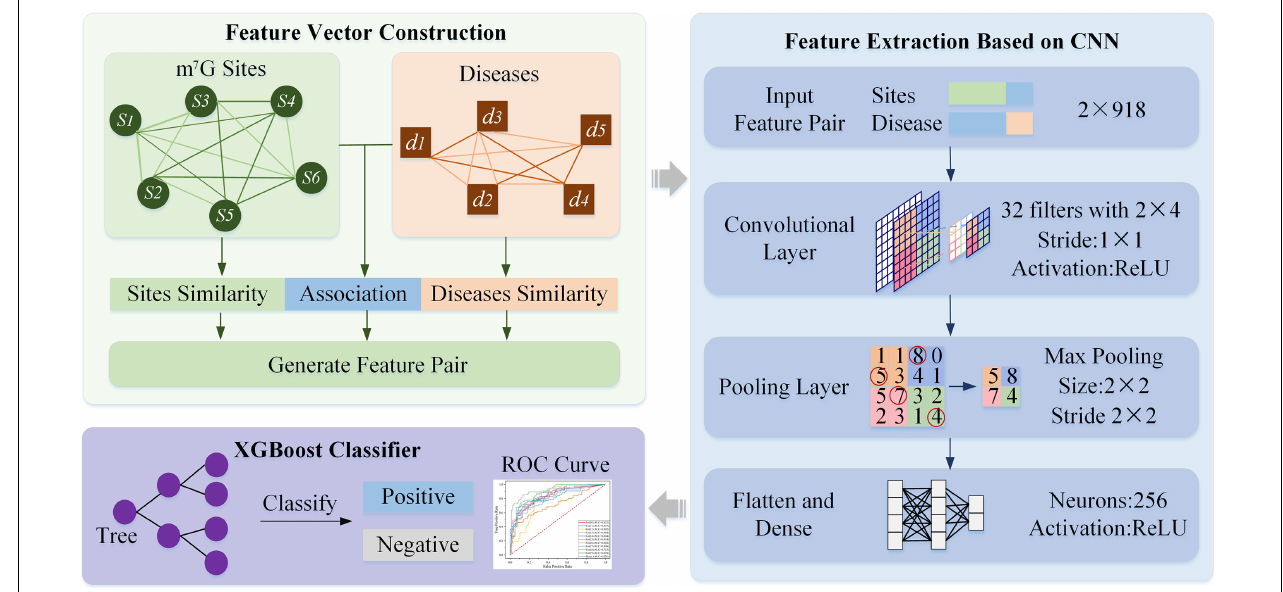
FIGURE 1 | Framework of HN-CNN. “Feature Vector Construction” is a heterogeneous network based on feature extraction, which is constructed with similarities and known m7G-disease association. “Feature Extraction Based on CNN” is a CNN-based feature extraction followed by XGBoost. In “XGBoost Classifier,” XGBoost predicts the candidate samples, which chooses the regression classification tree as a base